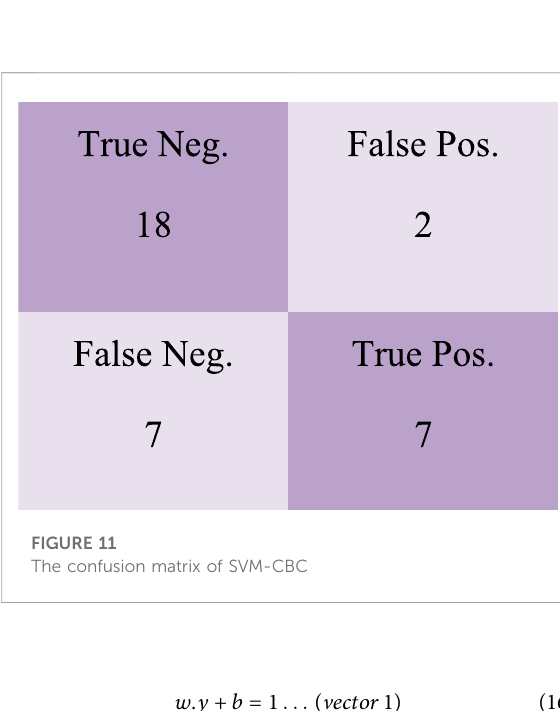
FIGURE 8 SVM-ABC classi fi cation model performance.